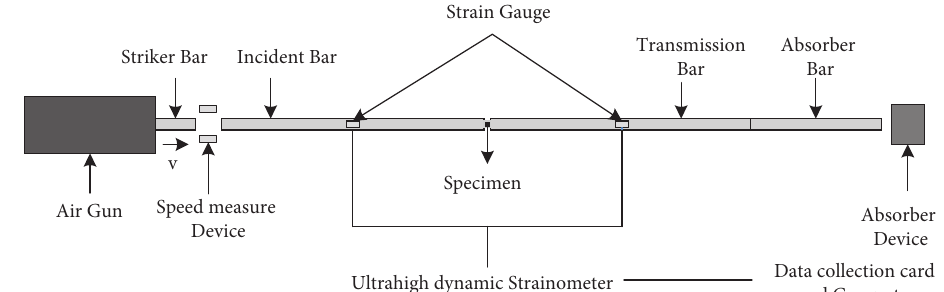
Figure 4: Schematic of the SHPB experimental